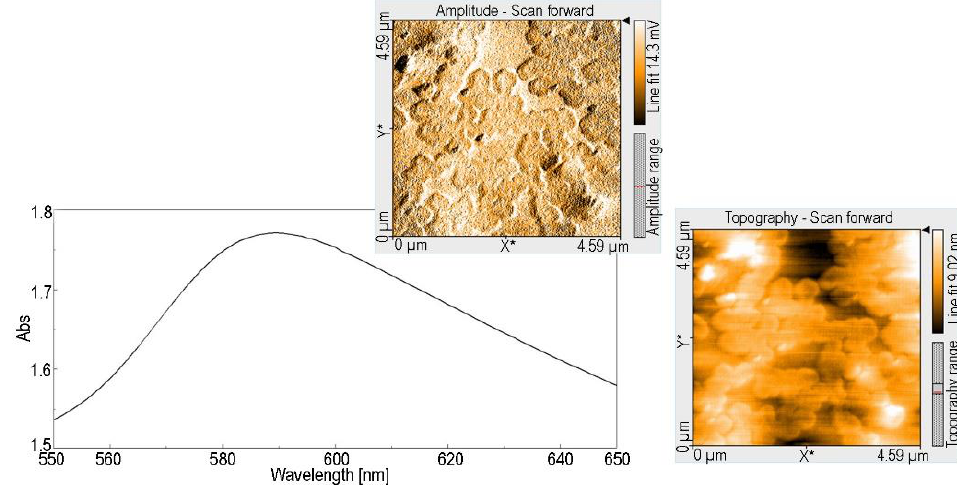
Figure 2. The UV-vis spectrum of Cu colloid solution (7.131 × 10 −4 M) and AFM images.